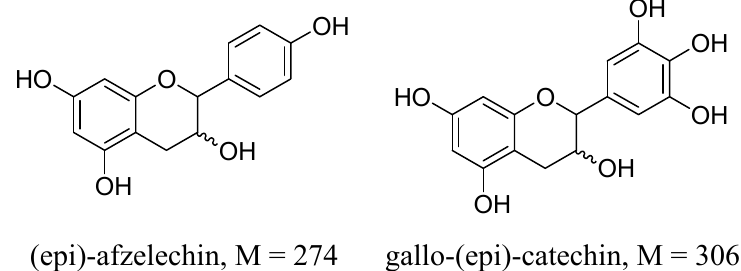
Figure 3. Chemical structures of compounds mentioned in